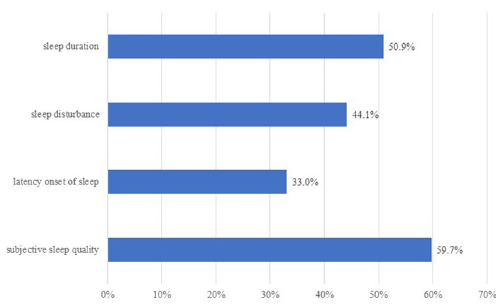
Figure 3. Proportion of participants with sleep quality